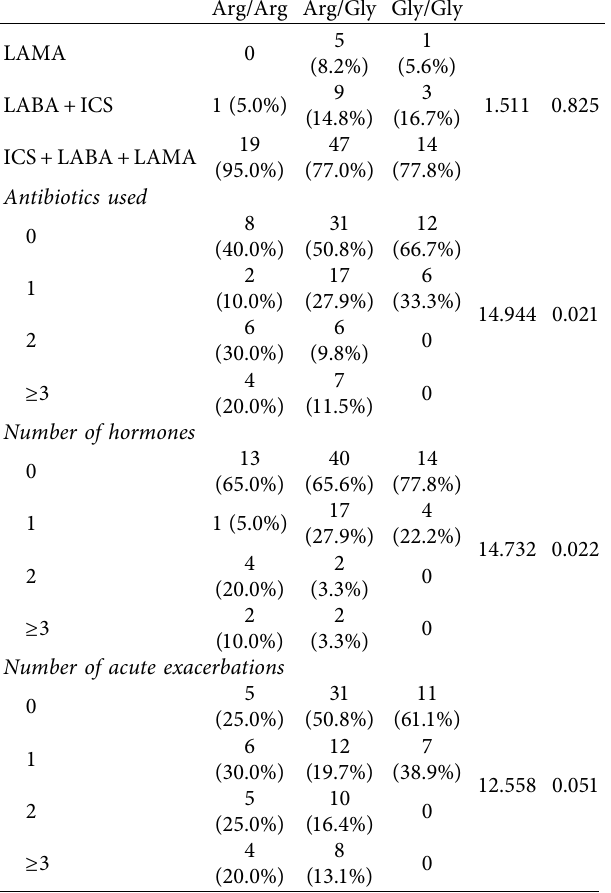
Table 2: Comparison of treatment methods for different genotypes.